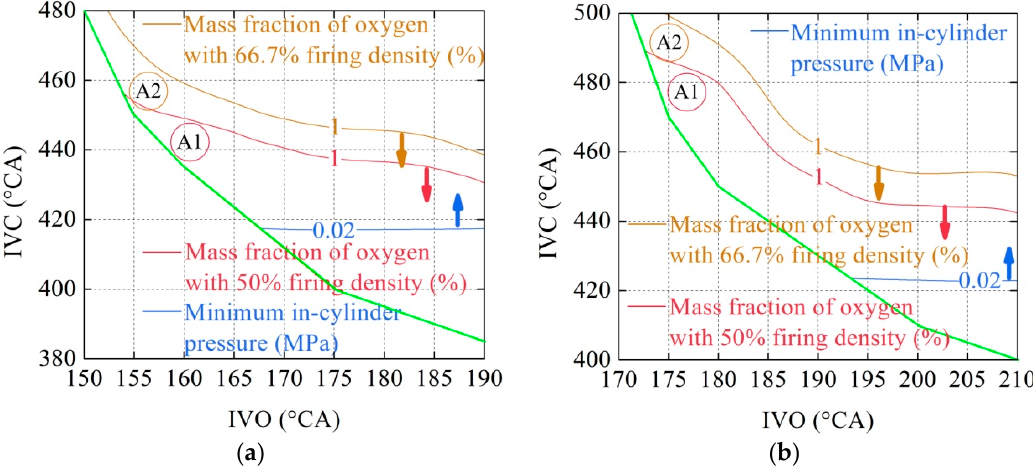
Figure 18. The optimal area of VCD operations: ( a ) 1200 rpm; ( b ) 1600 rpm.